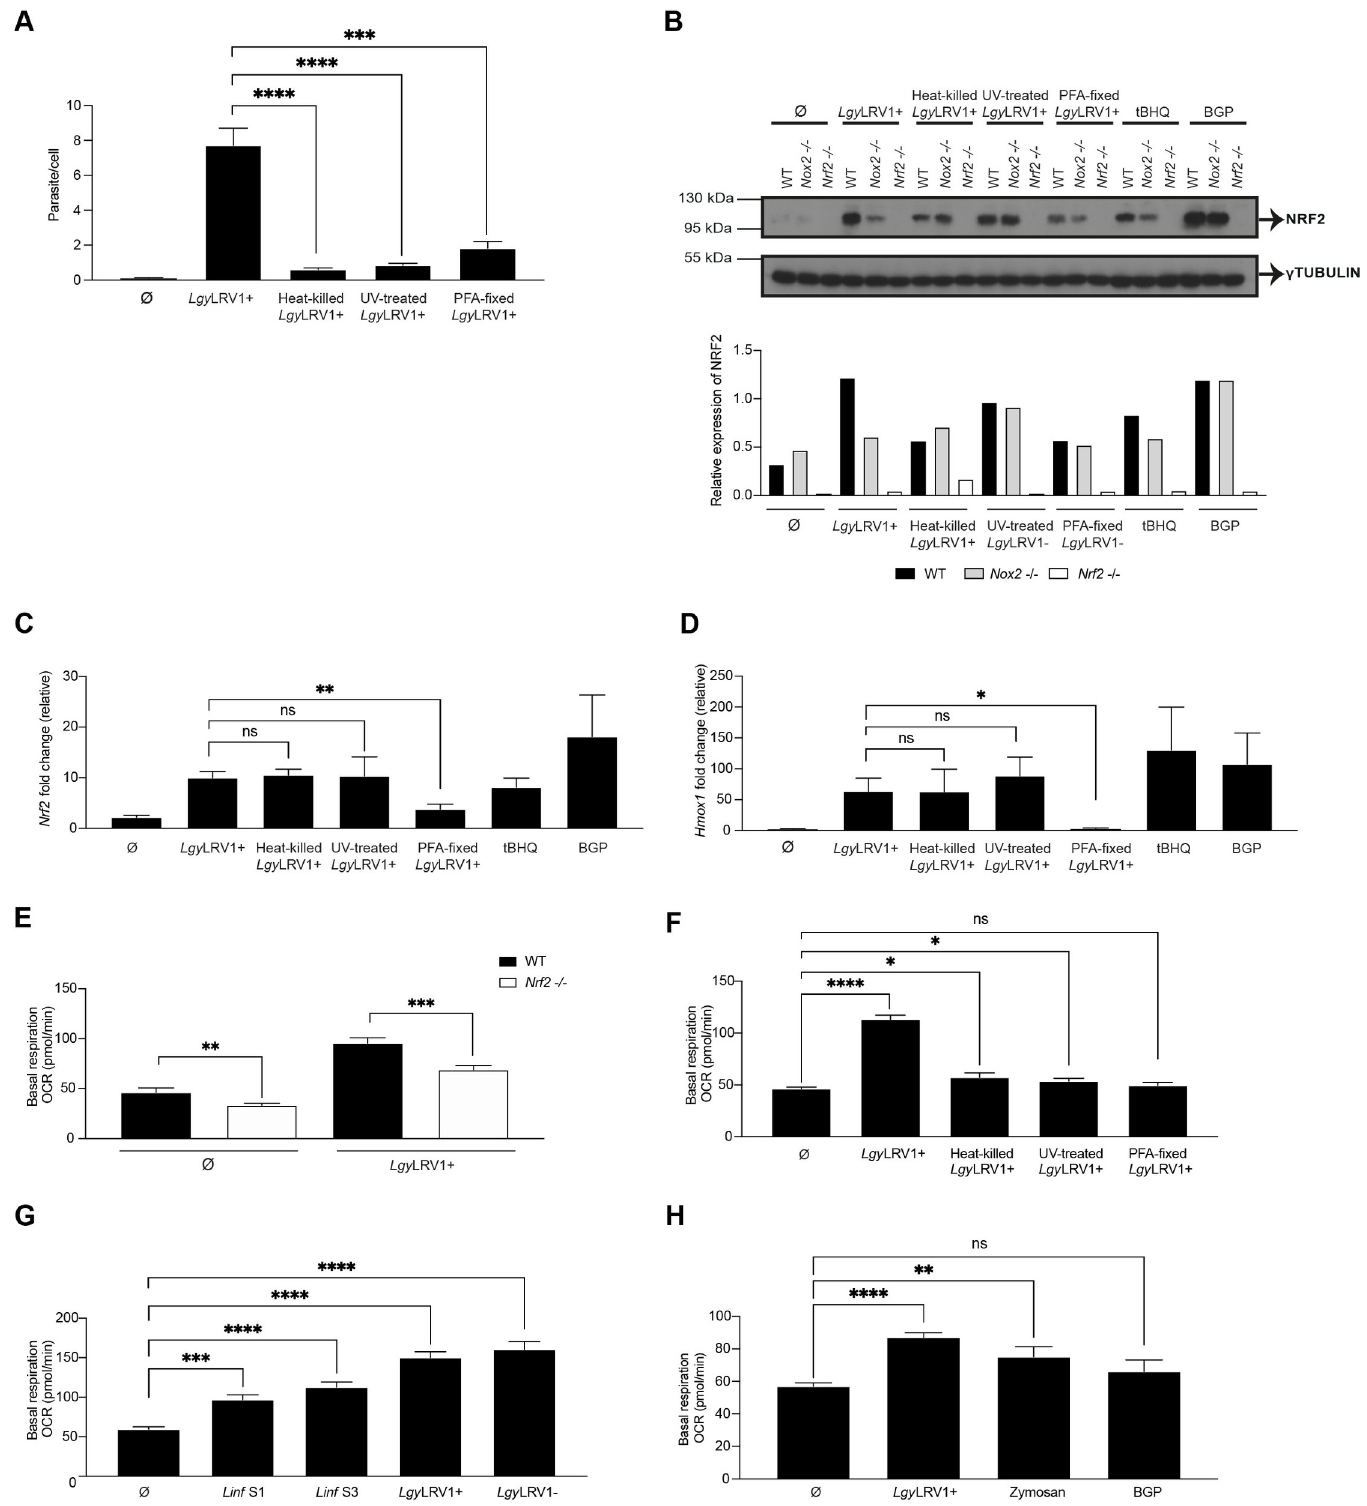
Fig 6. Initial contact of Leishmania with its host cell activated the NRF2 pathway and parasite entry strongly induced metabolic reprogramming. A) WT cells were infected with live, or heat-killed, or UV-treated or PFA-fixed Lgy LRV1+ parasites, or were non-infected ( Ø ) for 8 hrs. Intracellular parasite load was quantified by DAPI staining at 40x using a high-content microscope. Parasite load was quantified using MetaXpress software. B) WT, Nox2 -/- or Nrf2 -/- cells were either infected with live or